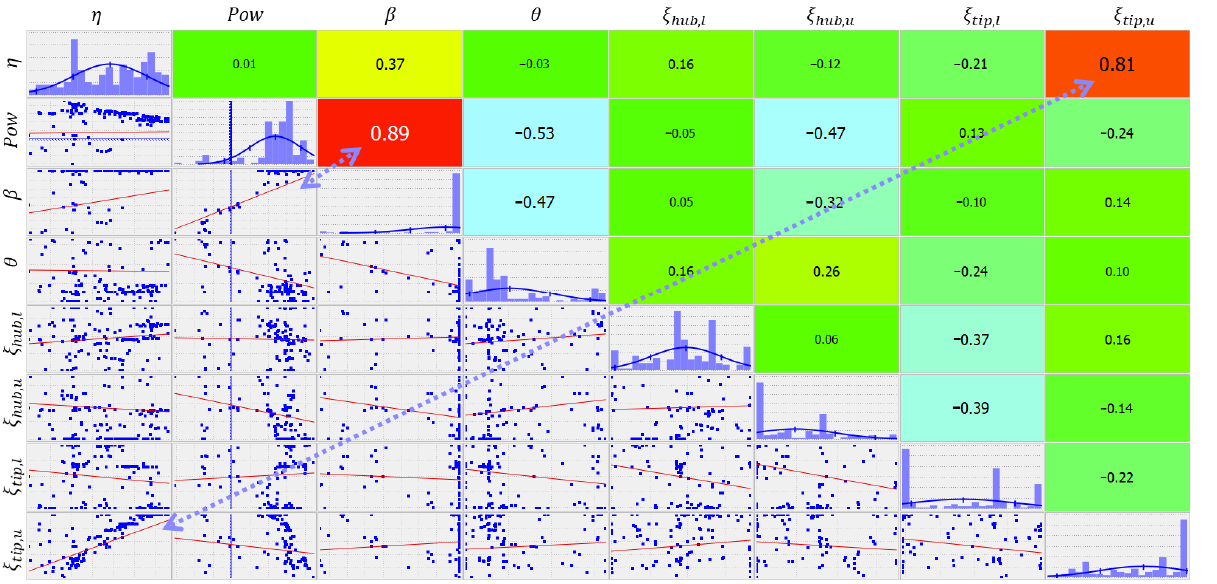
Figure 9. Correlation plot of selected design parameters of all designs. (The two most influential numbers and their corresponding plots are highlighted using the dashed arrows.)